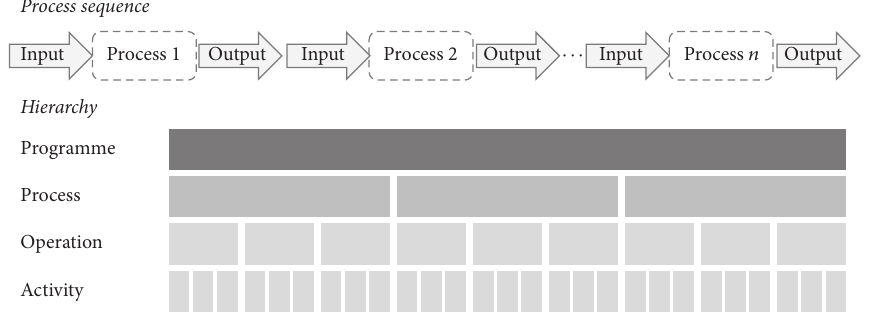
Figure 2: Process sequence and hierarchy (adapted from [7]).